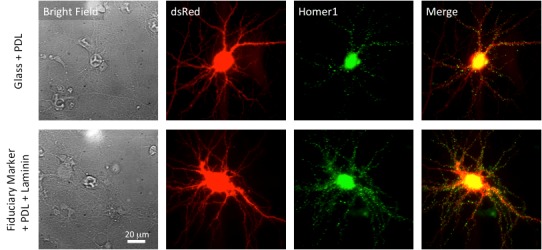
The upper panel represents cultured neurons on the poly-D-lysine (PDL) coated glass coverslip.The first column is bright field images. Red fluorescence is free ds-Red and green is homer1-mGEOS. The last column is overlay of ds-Red and Homer1-mGEOS. The lower panel is cultured neurons on the fiduciary marked coverslip with PDL and laminin coating. Before coating PDL/Laminin, fiduciary marked coverslips were treated with oxygen plasma to make hydrophilic surface. The neuron cultured on the fiduciary marked coverslip looks very similar to the neuron that cultured on the glass coverslip in terms of their shape and number spines. All images are taken with x60 water immersion Nikon objective lens (Plan Apo VC 60x WI).